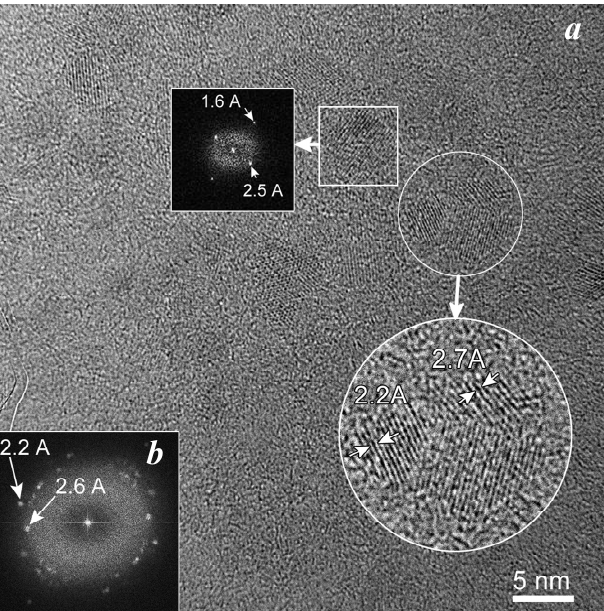
Figure 10. High resolution transmission electron microscopy image of ferritin ( a ) and the corresponding Fourier transform of 50 × 50 nm area ( b ). Some iron cores are enlarged and are shown in the insets. The iron cores in this image constitute ordered domains with lattice periodicities between 2.0 and 2.7 Å. Adapted from Ref. [51] with permission from Elsevier: Journal of Inorganic